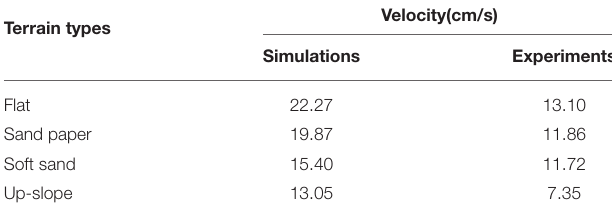
TABLE 8 | The maximum velocity in different terrains.